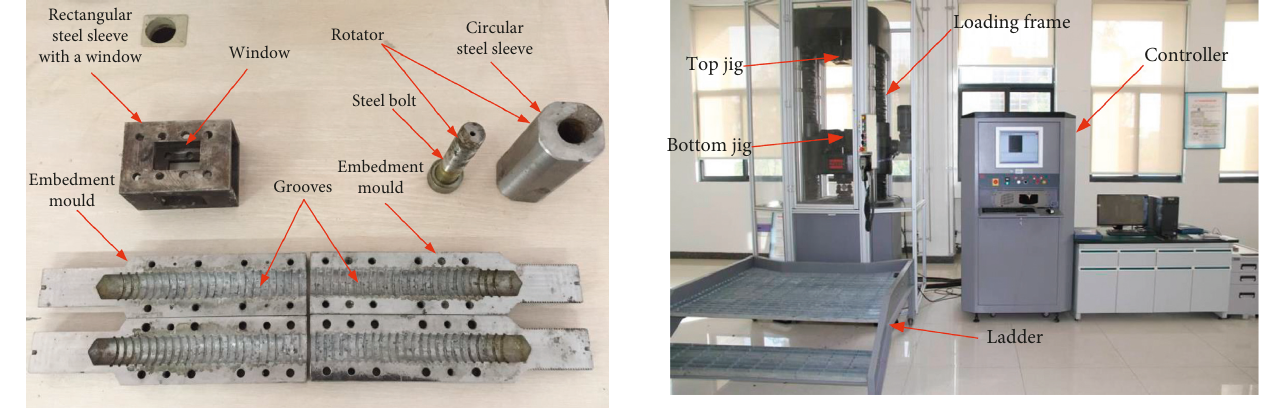
Figure 2: An over view of the MTS-815 testing machine used in the tests.